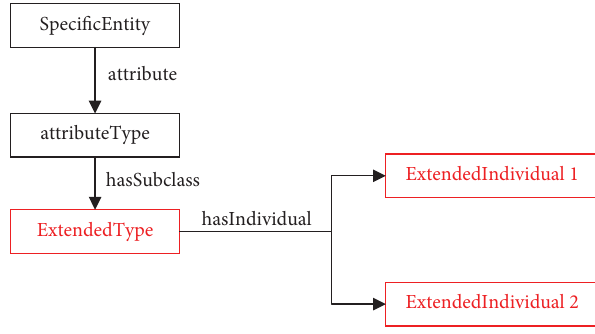
Figure 1: Attribute value extension